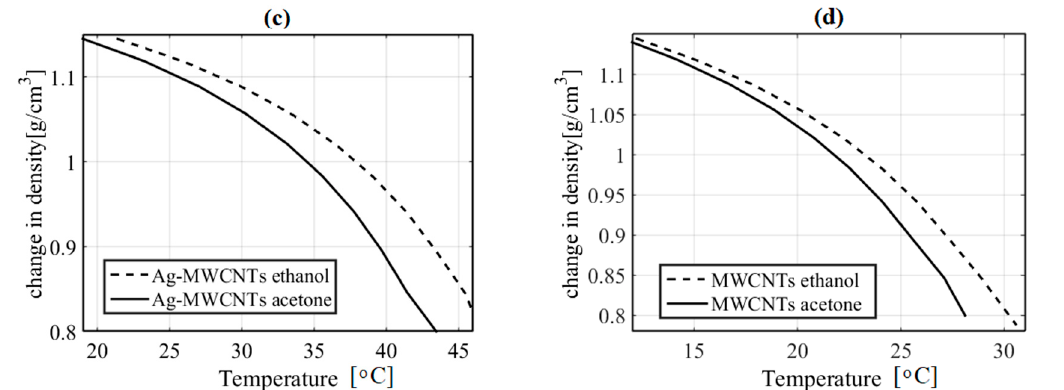
Figure 9. Numerical results of the induced change in density estimated by considering the change in refractive index in the nanofluids. ( a ) Ag-MWCNT samples, ( b ) MWCNT samples. Numerical results of the induced change in temperature estimated by the change in density in the nanofluids. ( c ) Ag-MWCNT samples, ( d ) MWCNT samples.